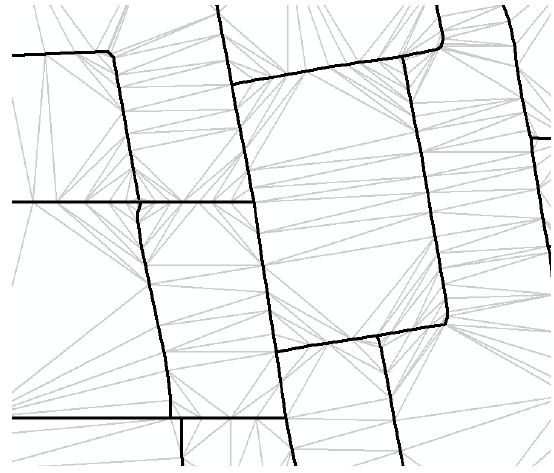
Figure 6. Extracting the proximity relation of road segments based on Delaunay triangulation.